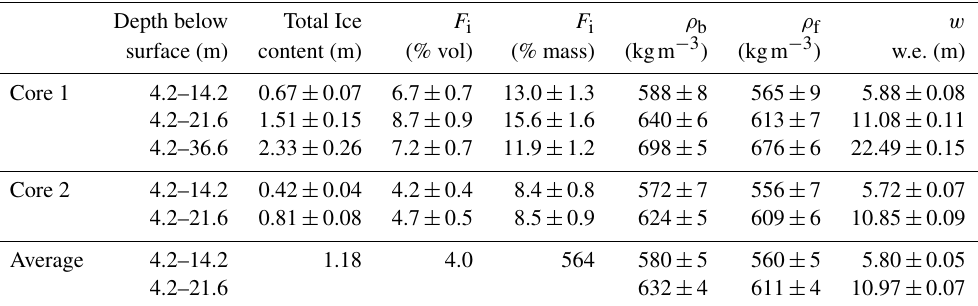
Table 1. Total ice content, ice fraction ( F i ), bulk density ( ρ b ), background density ( ρ f ), and total water equivalent ( w ) for the portion of each core below the last summer surface. Depths are reported from the May 2018 snow surface and the firn portion of the core started at the 2017 summer surface, at 4.2m depth.